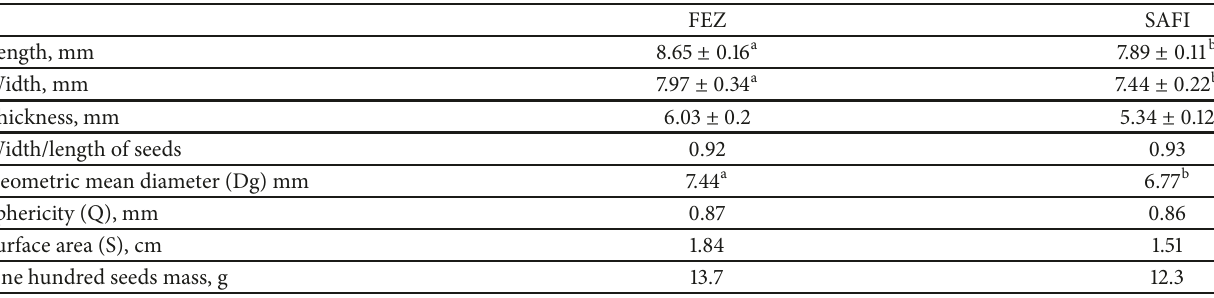
Values are mean ± standard deviation. Different letters indicate significant differences at p ≤ 0.05. Table 2: Morphological properties of Capparis spinosa